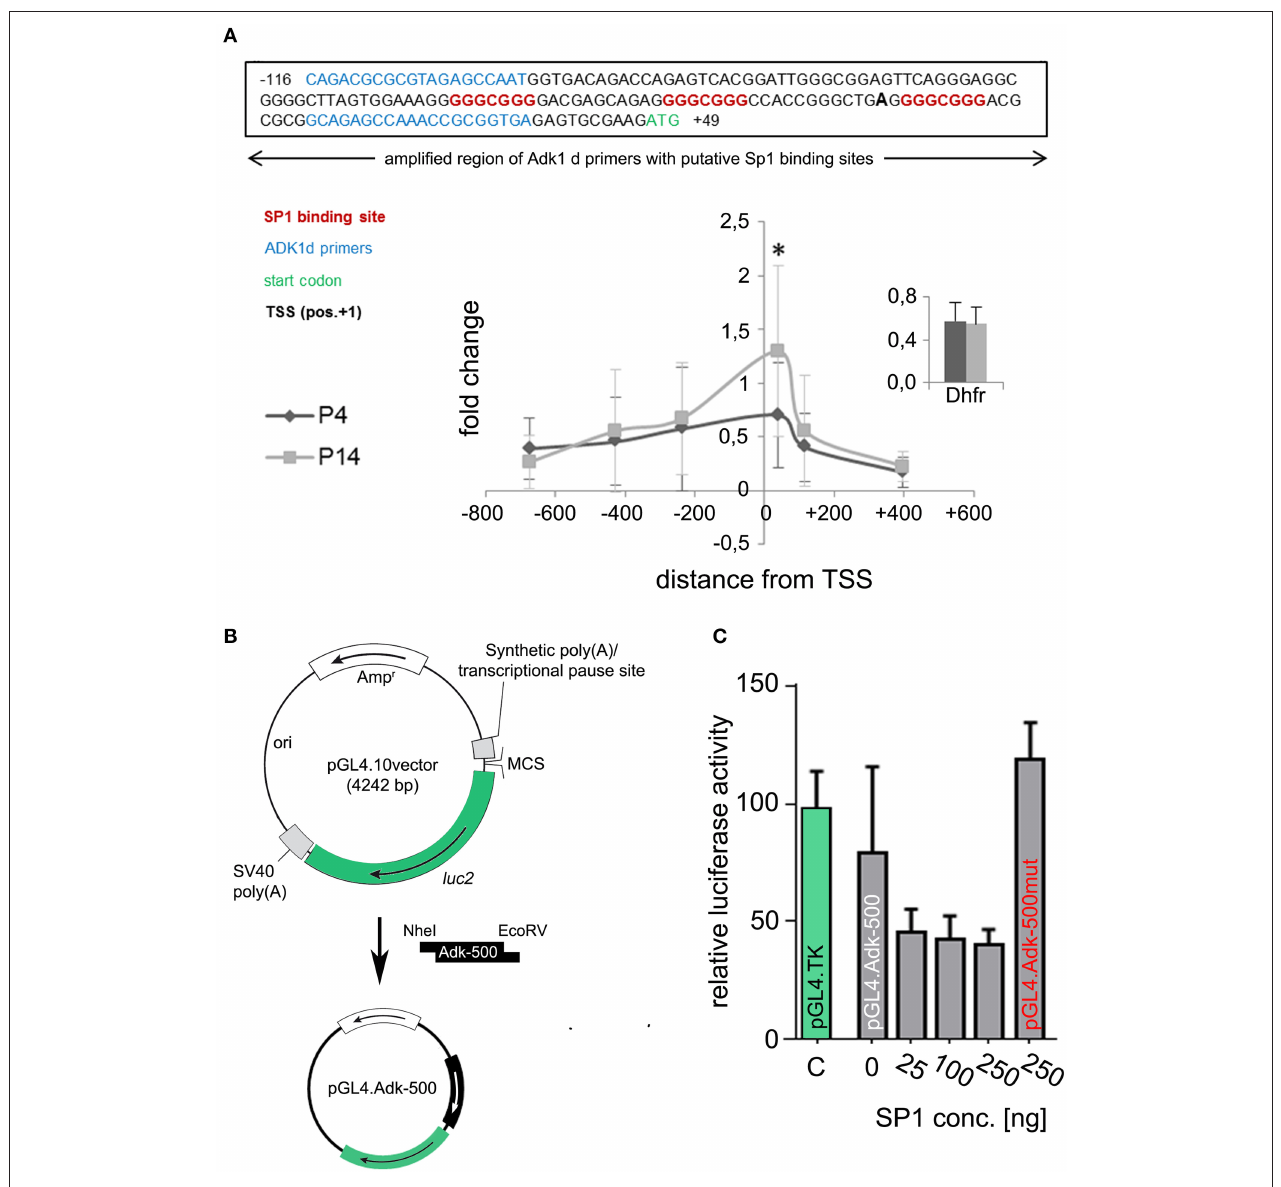
FIGURE 5 | Identification of transcription factor binding. (A) Upper panel: SP1 binding sites (indicated in red) at the amplified region of Adk 1d primers (indicated in blue) around the TSS (pos. + 1, bold). Lower panel: Binding of SP1 to the promoter region of the long Adk isoform are shown relative to a positive control primer in P4 and P14 rat hippocampal neurons. The analyzed promoter region spanned over 1 kb between position − 735 and + 470 relative to the TSS. There is significant enrichment of SP1 binding around the TSS of the Adk-L promoter in P14 rat hippocampal neurons, which may be implicated in the suppression of the long Adk isoform. Inset displays enrichment of positive control for Sp1 antibody presented as percent of the total input chromatin (% input). (B) Luciferase assay was performed to analyze the binding of SP1 to the Adk promoter and its impact on gene expression. Therefore, the Adk-L promoter including 1.000bp upstream the TSS was subcloned in front of luciferase 2 (luc2) gene in the pGL4.10 vector and transfected into HEK293 cells. Transfected cells were incubated with increasing concentrations of recombinant SP1 for 3 h and then used for luciferase activity measurements. (C) We identified a concentration dependent negative regulation of the Adk-L promoter and luc2 gene through transcription factor SP1. Adk, Adenosine kinase; Adk-L promoter, promoter regulating expression of the long Adk isoform; Ap3m1, adaptor-related protein complex 3, mu 1 subunit; ChIP, chromatin immunoprecipitation; CpG, cytosine guanine dinucleotide; DHFR, Dihydrofolate reductase; kb, kilobase; SP1, specificity protein 1;TSS, transcriptional start site. *indicates